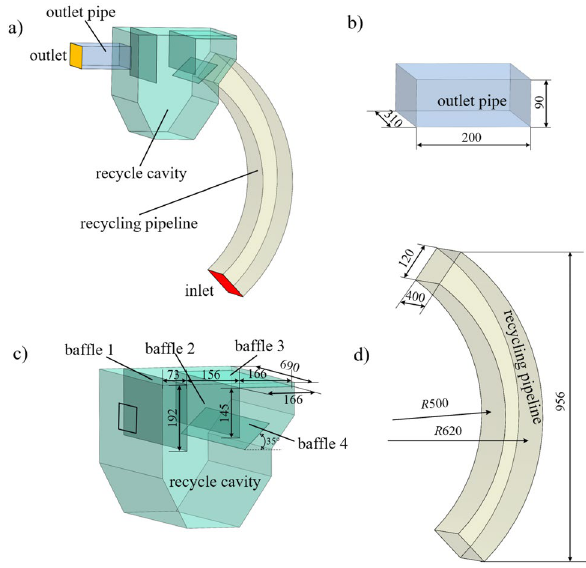
Figure 2. Shot blasting machine recovery device and dimensional drawing: ( a ) overall view of recovery unit; ( b ) outlet pipe; ( c ) recovery bin; ( d ) recovery pipe line.